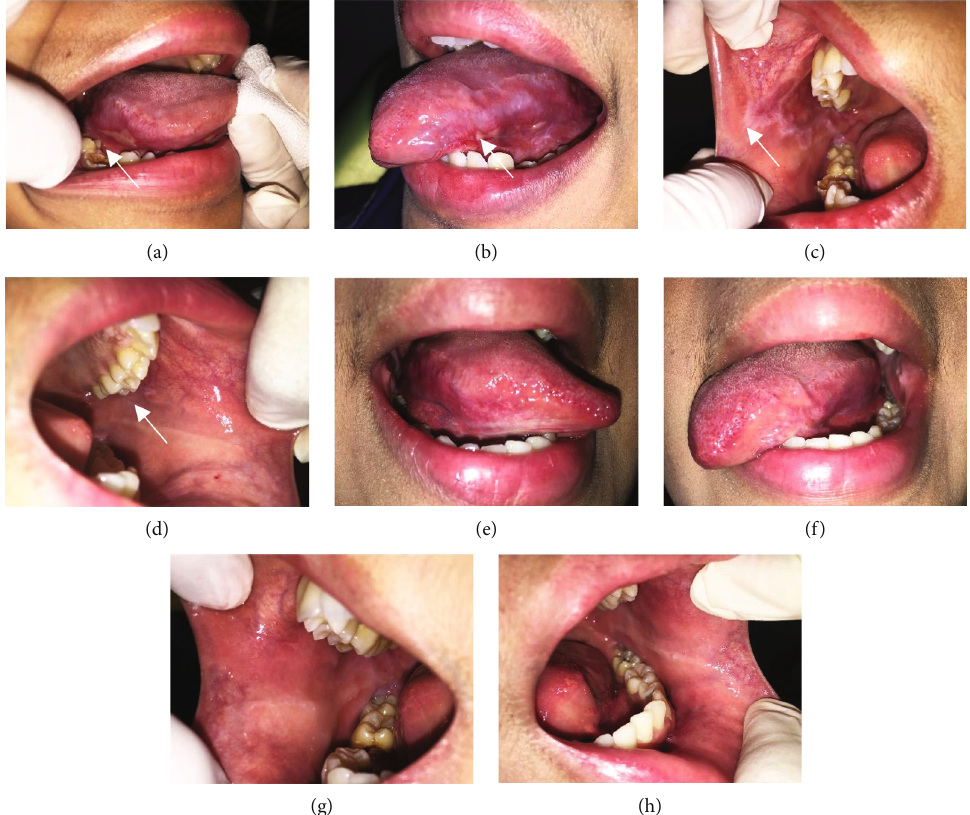
Figure 3: The clinical features of OLP in a 23-year-old woman; (a) and (b) yellowish pseudomembranous on the ventral of the tongue; (c) and (d) white plaques with striae surrounded by erythematous on the right and left buccal mucosa; (e) – (h) Oral lesion showed a signi fi cant improvement after two months of